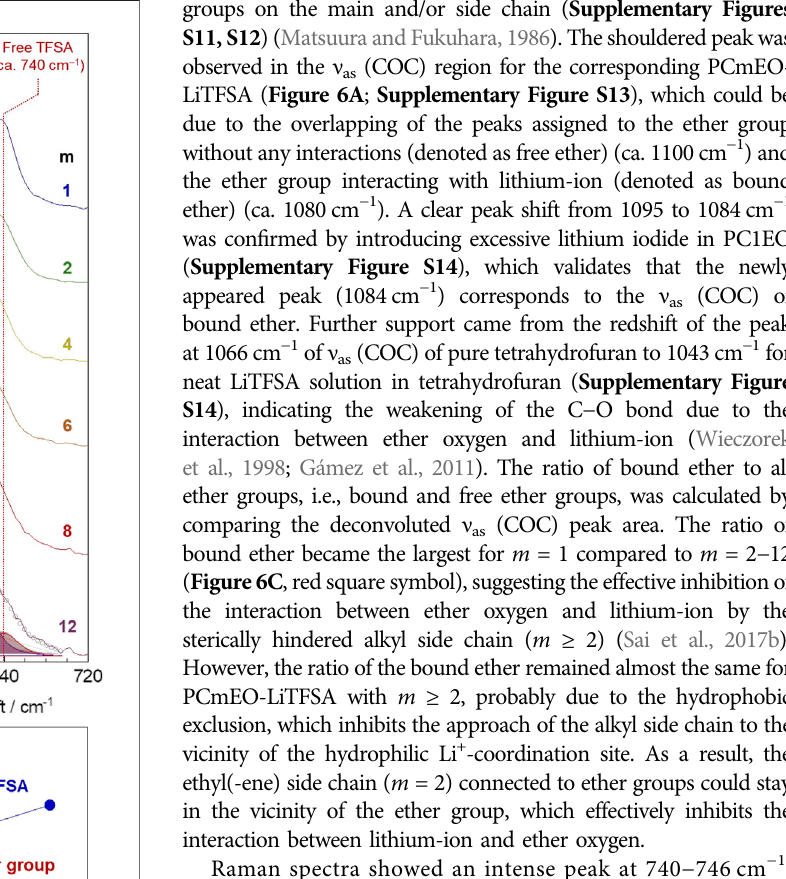
Frontiers in Chemistry |